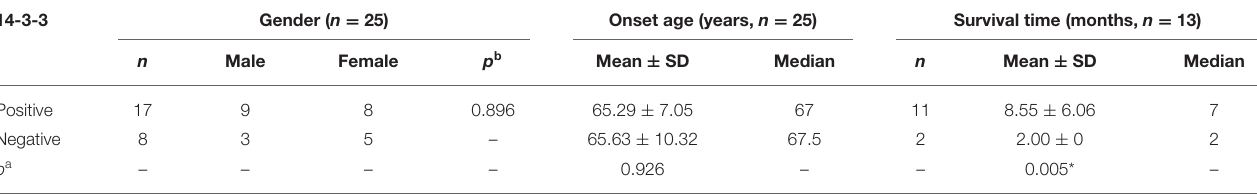
a Differences in mean age and mean survival time between two groups (14-3-3 positive and 14-3-3 negative) were analyzed by Mann–Whitney U-test method. b The relationship between 14-3-3 protein positive and gender was analyzed by Spearman correlation analysis method. * p <